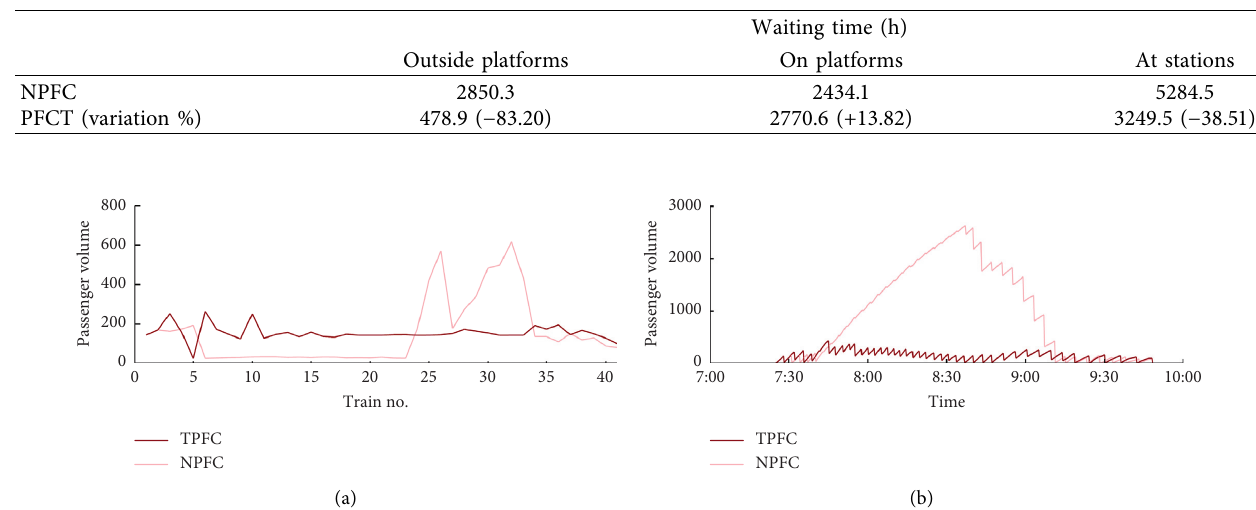
Table 7: Passenger waiting time.